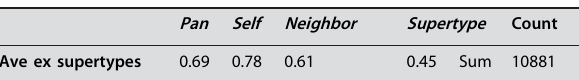
Table 2. Performance for the different alleles in terms of the Pearsons correlation for the ‘‘leave-one-out’’ experiment with